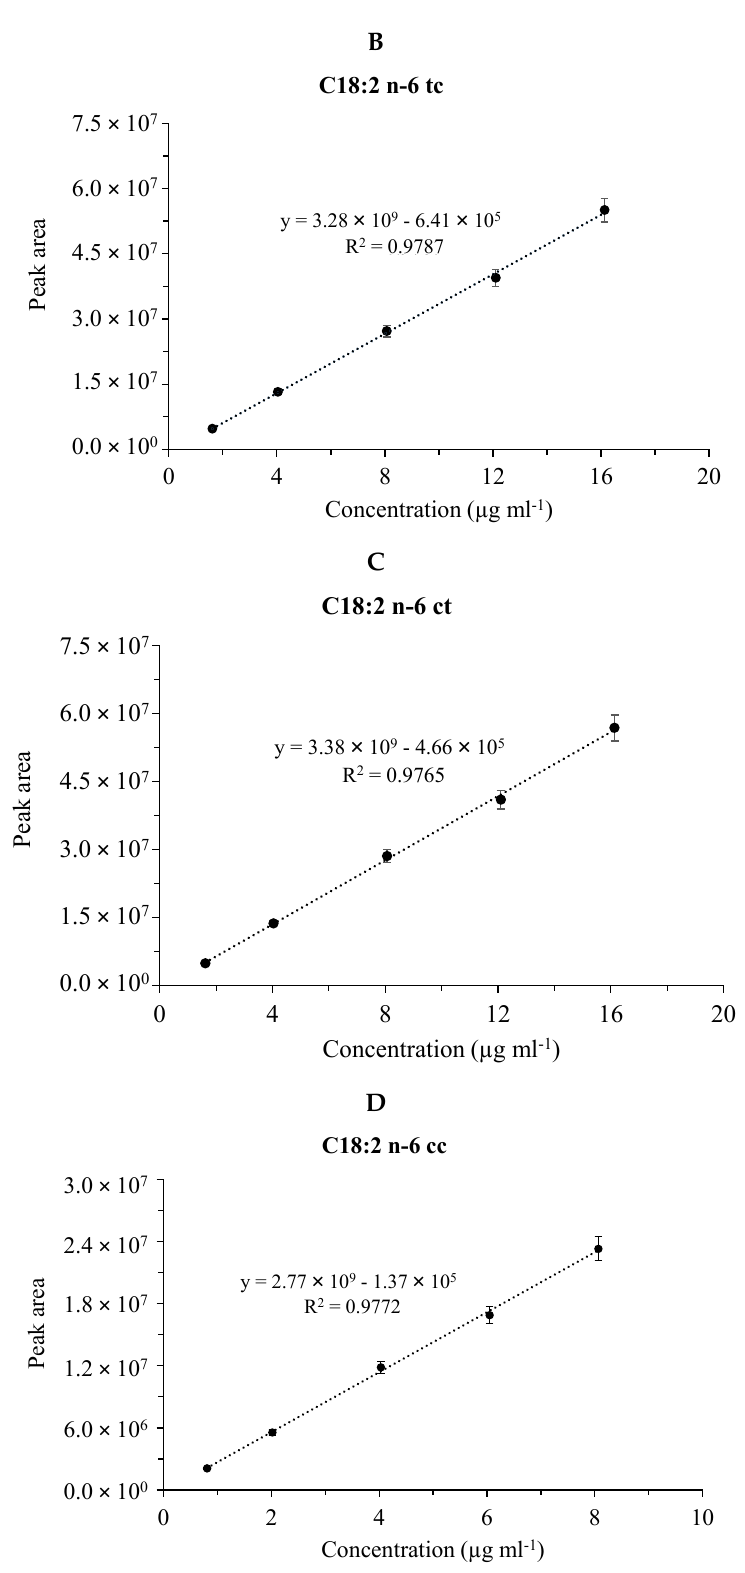
Figure 3. Calibration plots for fatty acid methyl esters in the CRM47741 mixture. Cumulative graph of the assay in the range of 0.008–0.08 mg mL − 1 with 5 points of calibration in three (n=3) separate calibrations, mean values of calibration concentrations represented by dots and ± SDs. ( A ) C18:2n-6tt, ( B ) C18:2n-6tc, ( C ) C18:2n-6ct and ( D ) C18:2n-6cc analyzed by the SLB-IL111 GC col- umn.